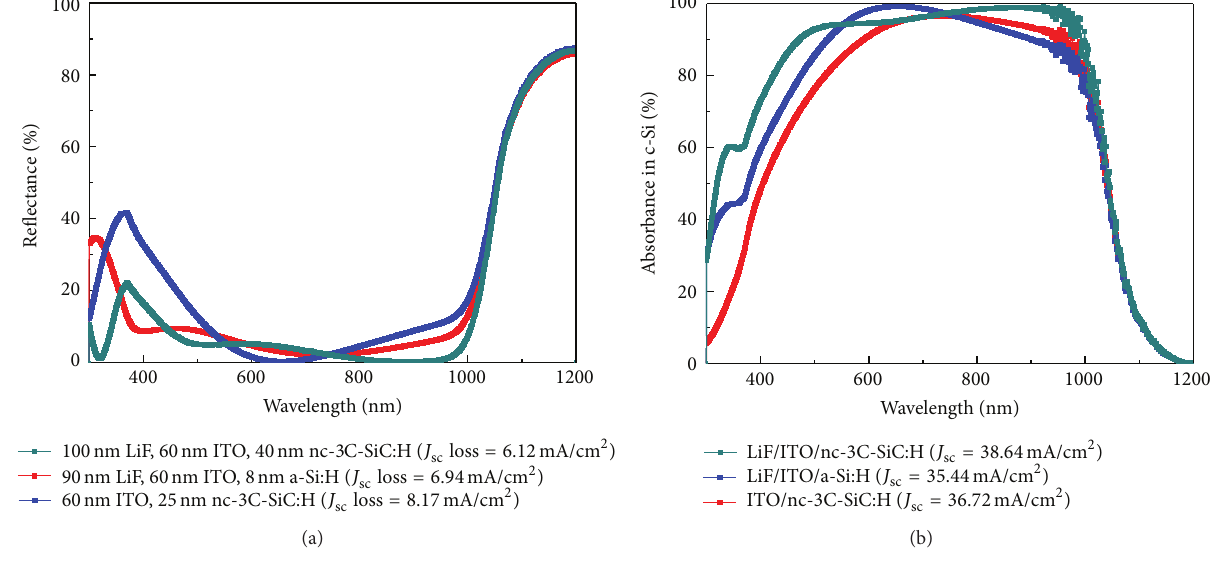
Figure 5: (a) The reflectance spectra on three SHJ solar cells with nc-3C-SiC:H emitter with only ITO, with ITO and LiF dielectric, and SHJ solar cell with a-Si:H emitter, ITO, and LiF dielectric. (b) The corresponding absorbance in c-Si of those SHJ structures.